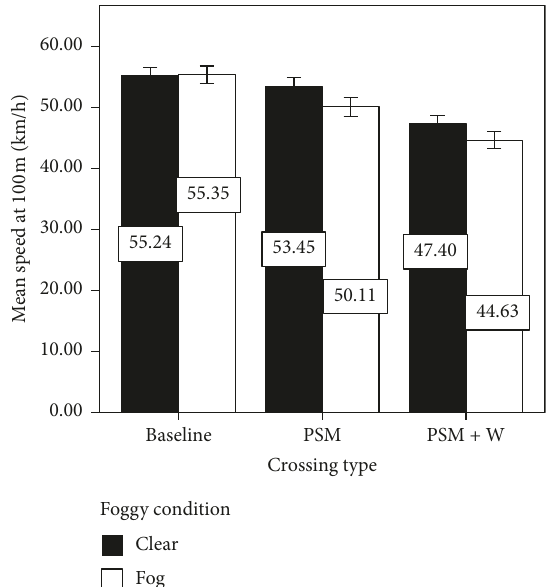
Figure 9: Mean speed at 100m to the crossing for the interaction between crossing type and foggy condition.